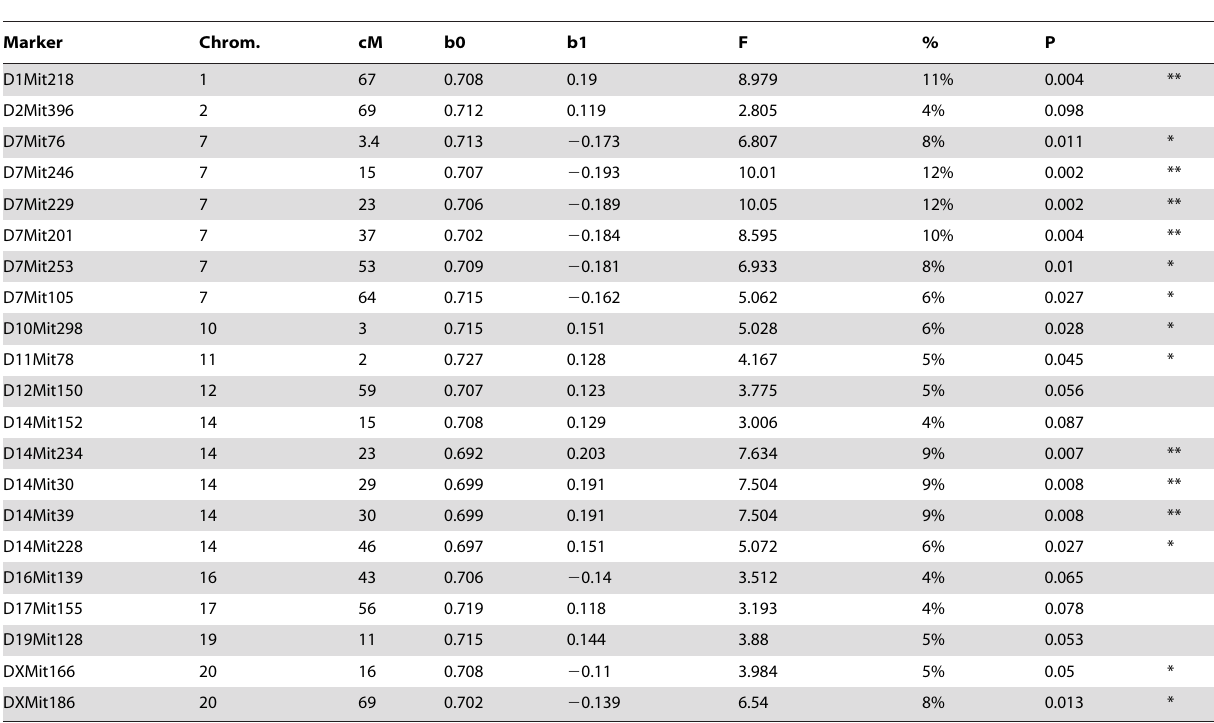
Table 1. Markers showing near-significant and significant association with bFGF-induced corneal neovascularization in a 77- animal C57BL/6J 6 129P1/ReJ F2 cross.